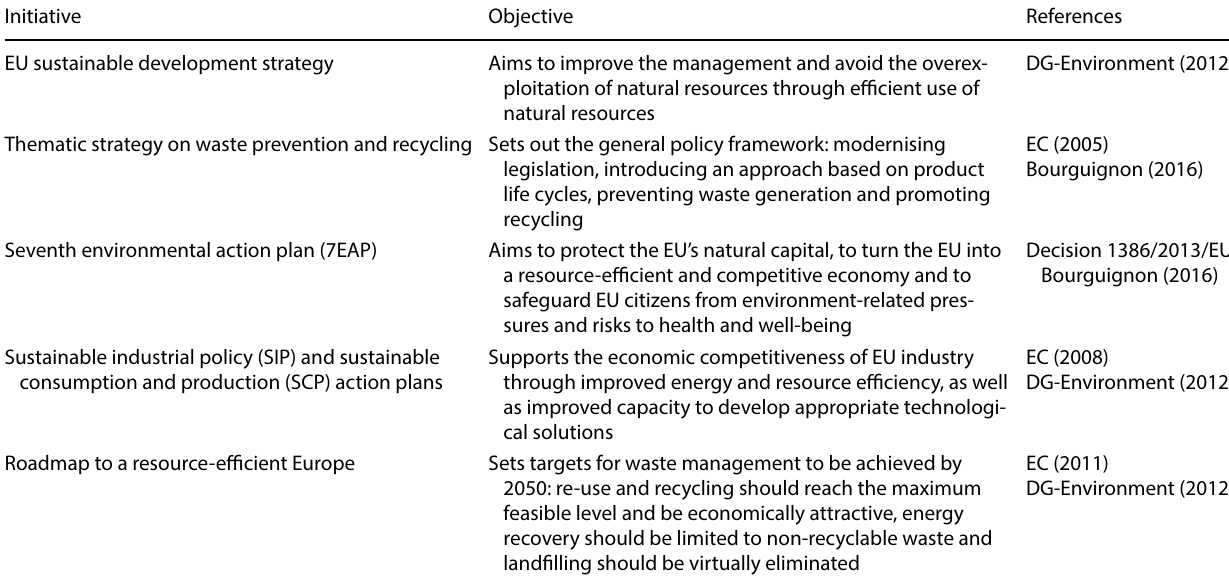
Table 1 European strategies which fall under the scope of the circular economy package Initiative Objective